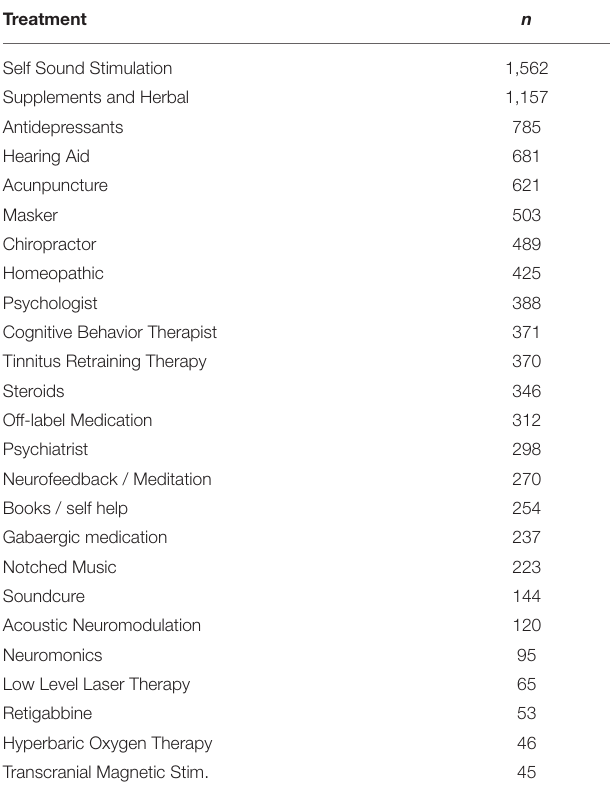
TABLE 1 | Sample size of each